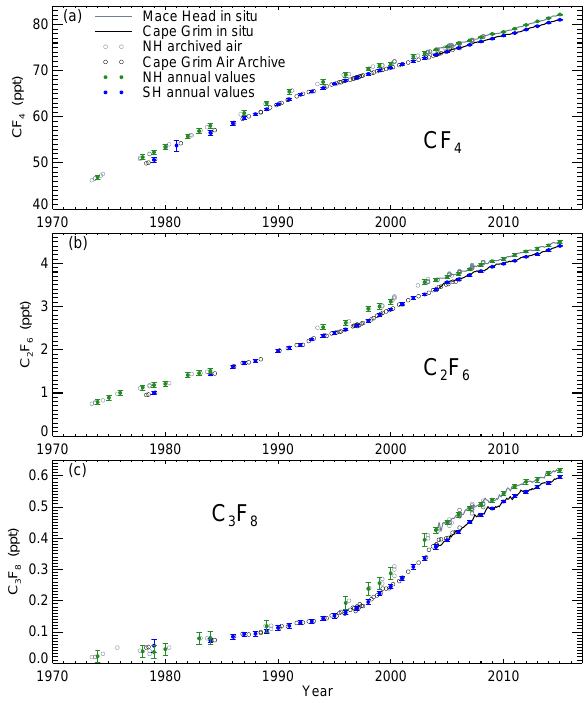
Figure D1. (a) Mace Head and Cape Grim in situ monthly CF 4 are shown by the solid lines. Cape Grim air archive and northern hemispheric air archive measurements are the open circles. Blue and green circles show selected northern hemispheric (NH) and south- ern hemispheric (SH) annual values from a spline fit to the obser- vations that has 50% attenuation at periods of 1 year. Error bars show 1 σ uncertainties assigned to the annual means and used in the synthesis inversion. (b) Same for C 2 F 6 . (c) Same for C 3 F 8